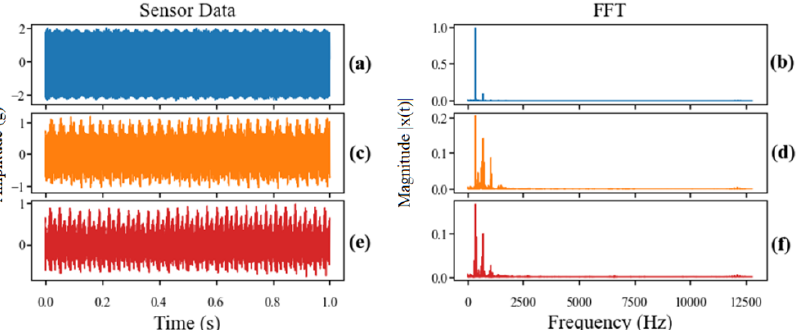
Figure 8. Sensor B signals. ( a ) Healthy, ( b ) Healthy FFT, ( c ) Fault-1 ( d ) Fault-1 FFT, ( e ) Fault-2, ( f ) Fault-2 FFT.